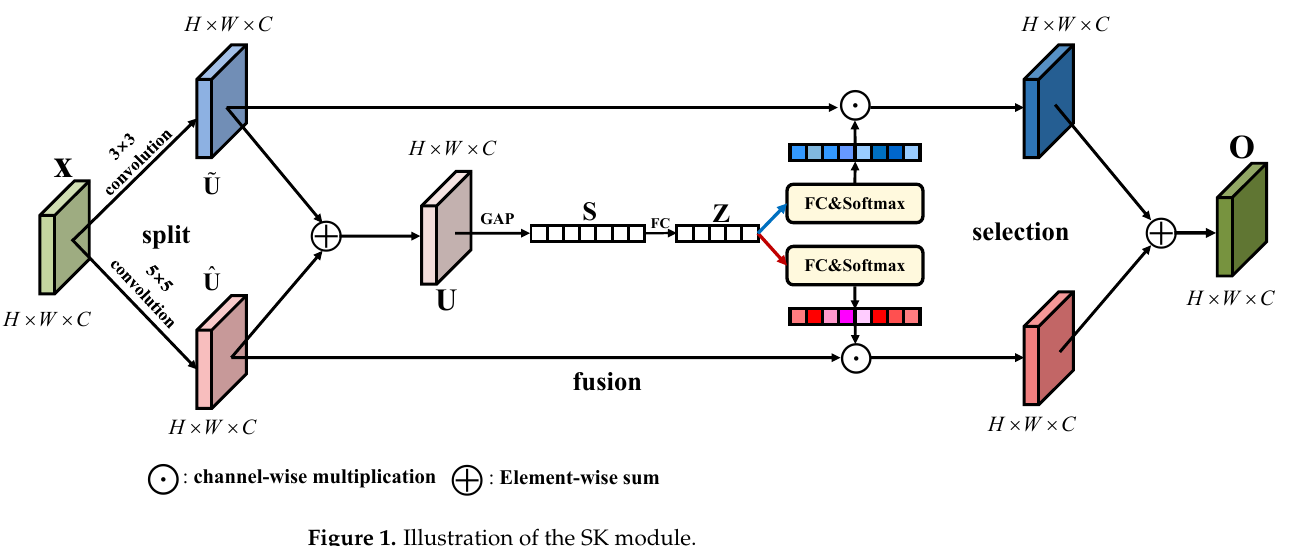
Figure 1. Illustration of the SK